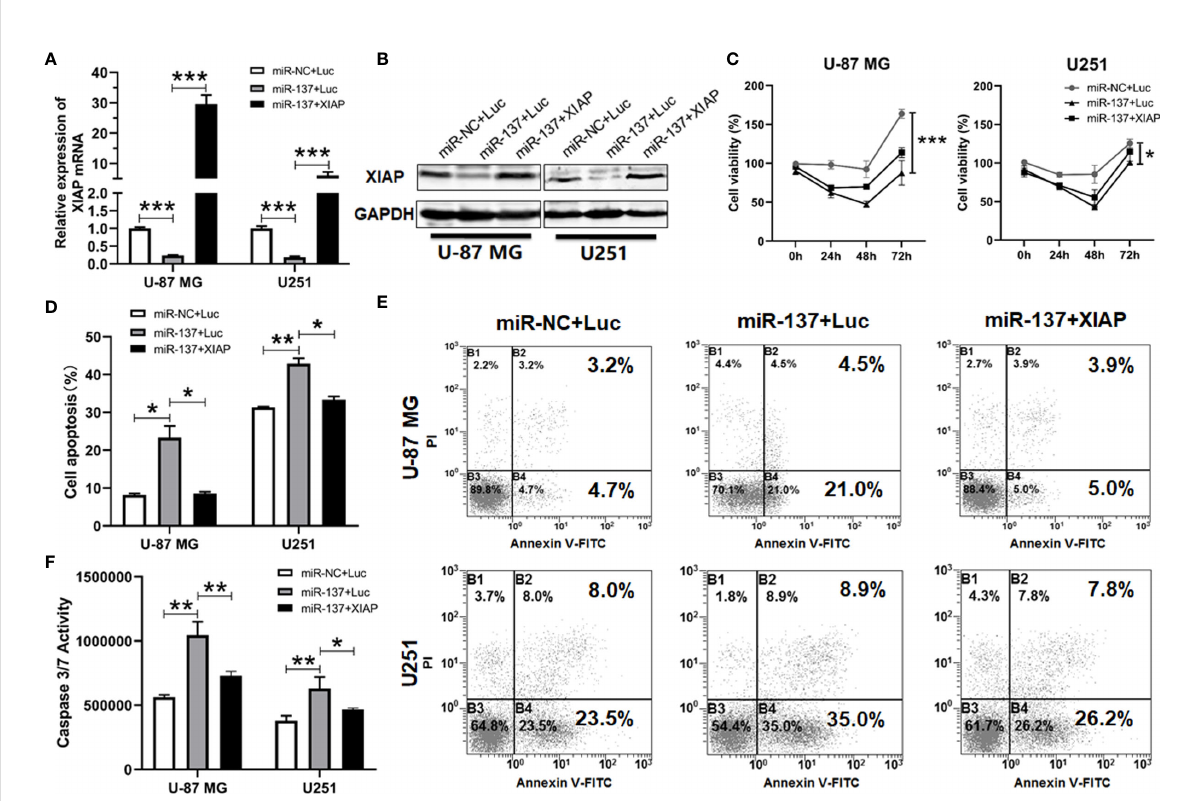
FIGURE 6 XIAP treatment abrogated miR-137-increased sensitivity to TRAIL-induced apoptosis in glioblastoma cells. (A) qRT-PCR and (B) Western blotting analyses of XIAP expression in miR-NC/137 with/without XIAP-treated sets in U-87 MG and U251 cells. The analyses were performed 48 h after treatment. (C) Cell viability of U-87 MG/U251 cells treated with different molecules and TRAIL determined by CCK-8 assay. (D) Flow cytometry analyses for cell apoptosis. Cells were initially treated with above sets 24 h followed by 48 h TRAIL treatment, then were determined by FCM analysis with Annexin-V and PI staining. (E) Representative pictures of cell apoptosis. (F) Caspase-3/7 assay after treatment with miR-NC/137, Luc/XIAP and TRAIL. Cell apoptosis re fl ected by caspase-3/7 activity. [Data were presented as mean ± SD of different groups, n = 3. * P <